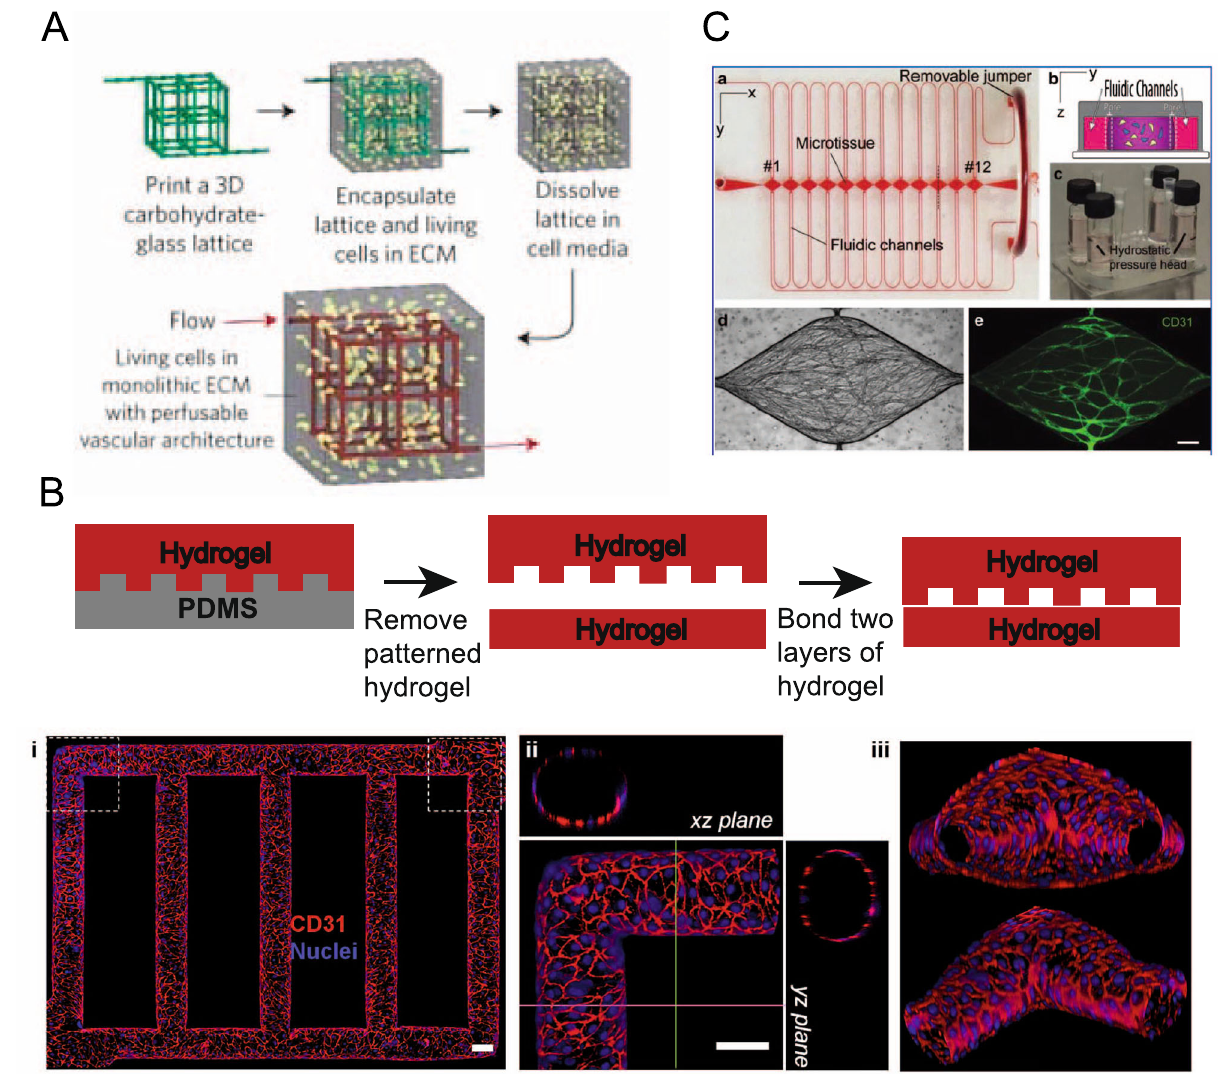
Fig. 2 Micro fl uidic approaches to in vitro microvascular engineering. a Schematic of self-supporting 3D printed carbohydrate-glass lattice that is encapsulated. Once the lattice is dissolved, a perfusable network results. Living cells can be placed within the ectracellular matrix and within the perfusable channels. b ( Left ) Schematic protocol of micro fl uidic device construction by bonding micropatterned hydrogel and thin layer to form microvascular channel network. ( Right ) Top and cross-sectional views of confocal Z -stacks showing endothelial-lined microvascular channels. Red is CD31 and blue are nuclei. Scale bar is 100 μ m. c ( Top ) Micro fl uidic platform made from PDMS that consists of a daisy chain of microtissue chambers connected by pores and loaded with extracellular matrix, endothelial cells, and fi broblasts. ( Bottom ) Bright fi eld and CD31 immuno fl uroescent staining demonstrating microvascular networks formed by endothelial self-assembly. Scale bar is 200 μ m. Figures reproduced and modi fi ed from [46, 47, 48] with permissions from Nature publishing, PNAS, Tissue engineering part c . Scale bar is 50 μ